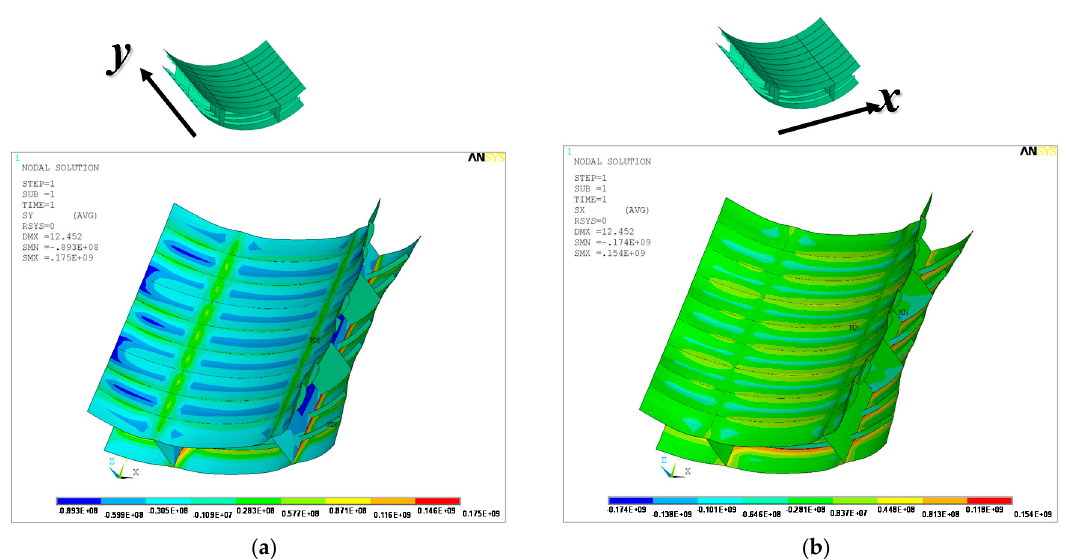
Figure 15. Stress distribution of a curved double bottom block: ( a ) y -direction, ( b ) x -direction.